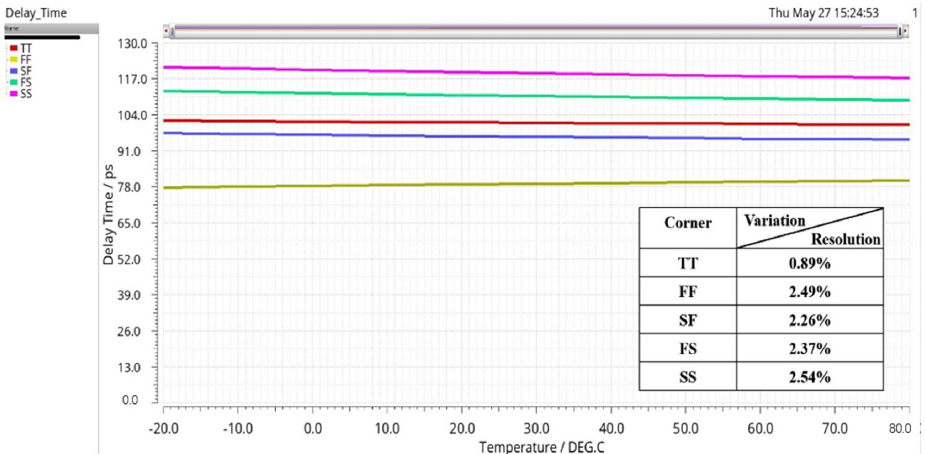
Figure 8. Simulated delay time of the delay unit in the CTDC and the variations of the delay time normalized to the resolutions at five different corners. The resolutions are 100.6 ps, 77.8 ps, 94.5 ps, 109.7 ps and 117 ps at TT, FF, SF, FS and SS corners respectively.